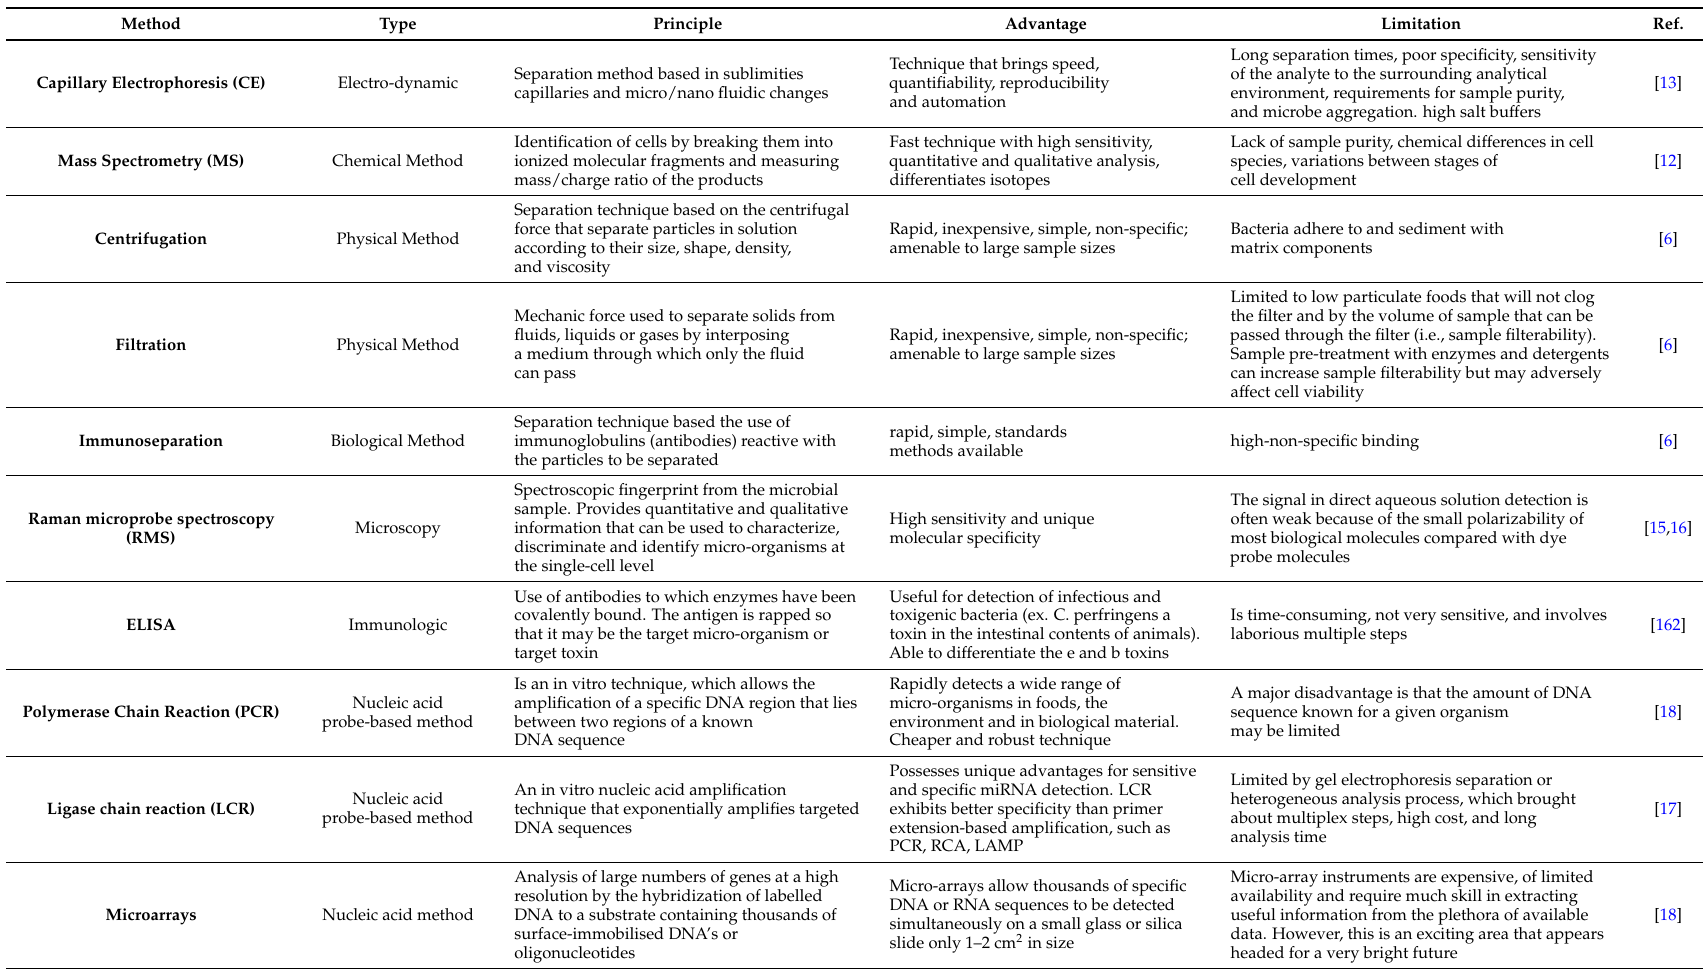
Table A1. Conventional bacteria concentration and detection